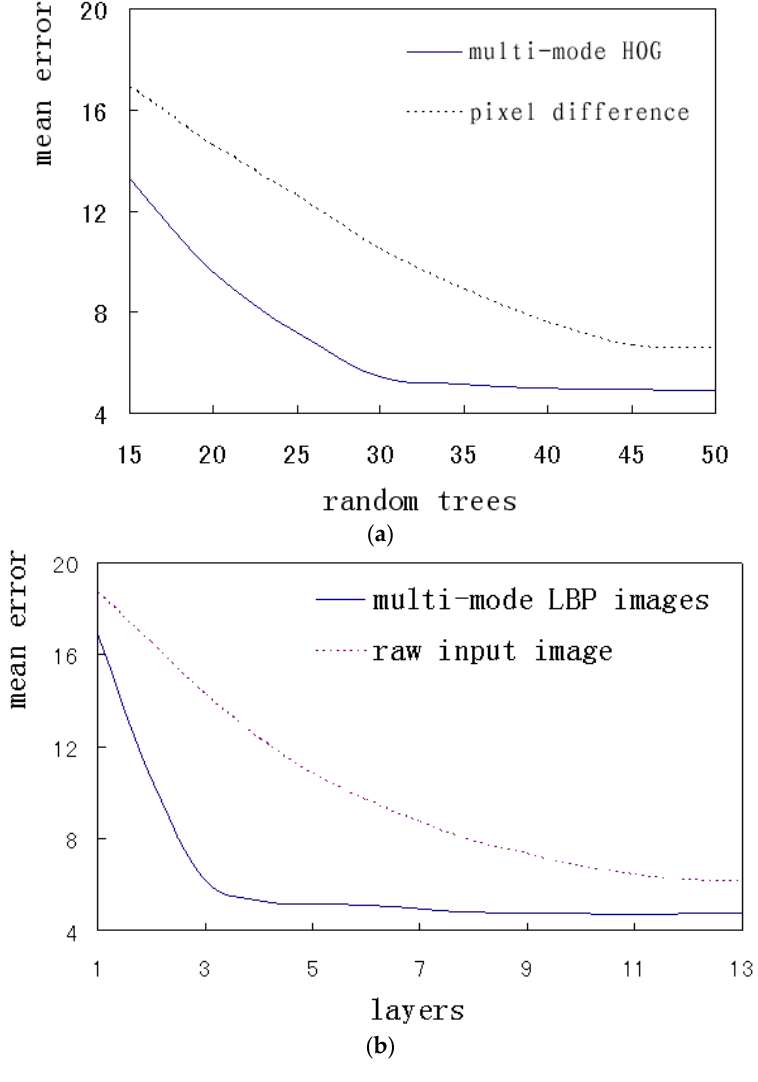
Figure 14. The error distribution of the different methods.